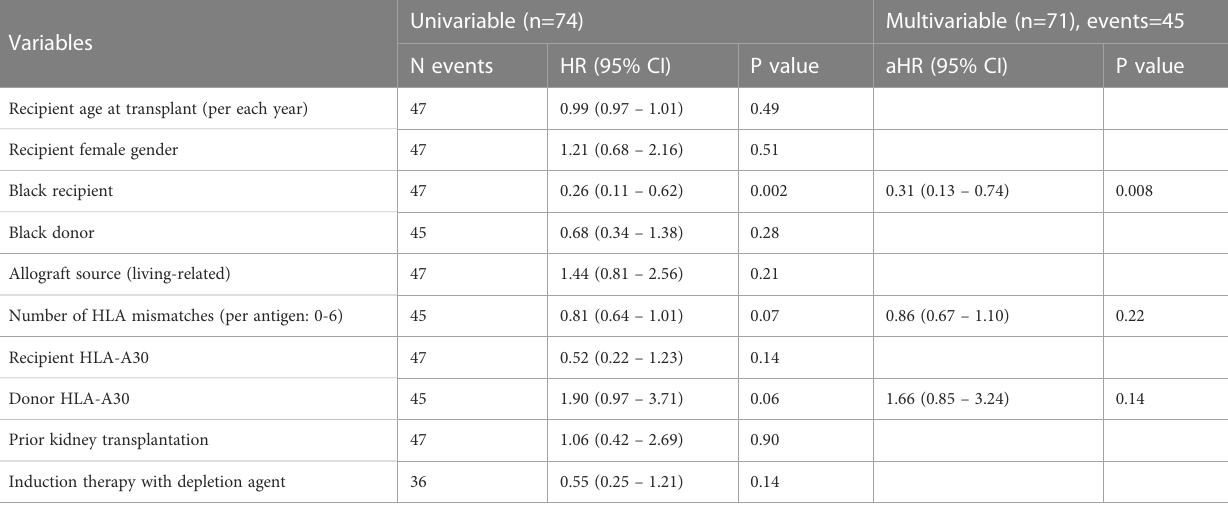
TABLE 1 Univariable and multivariable analyses of the associations with recurrent disease in patients with end stage kidney disease due to diffuse podocytopathy. Univariable (n=74) Multivariable (n=71), events=45 Variables